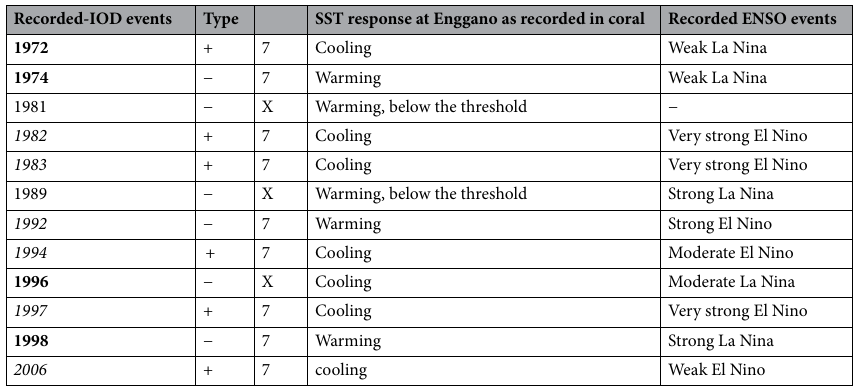
Table 1. IOD response seen in the Enggano coral record. 7: IOD/ENSO events and response seen in the Enggano coral record. Bold: the La Nina years. Italics: the El Nino years. Black (X): not recorded/no event.